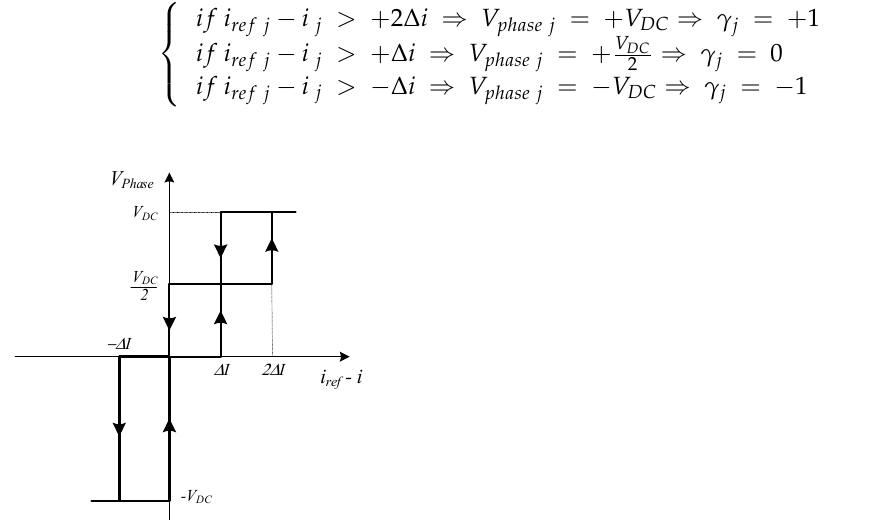
Figure 9. Proposed multilevel comparator for the current controller.